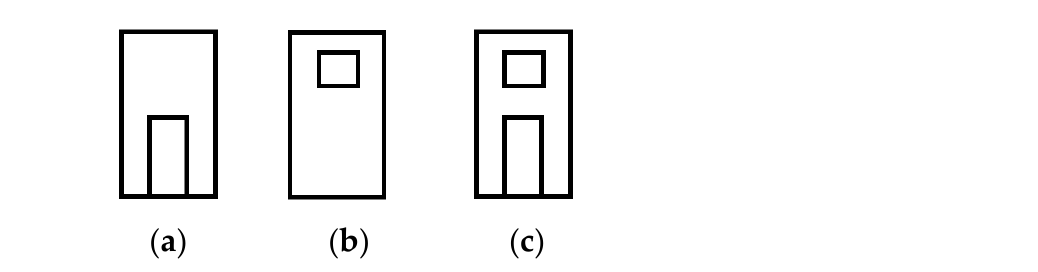
Figure 6. 2D layers related to the terrain over Torriani’s map.